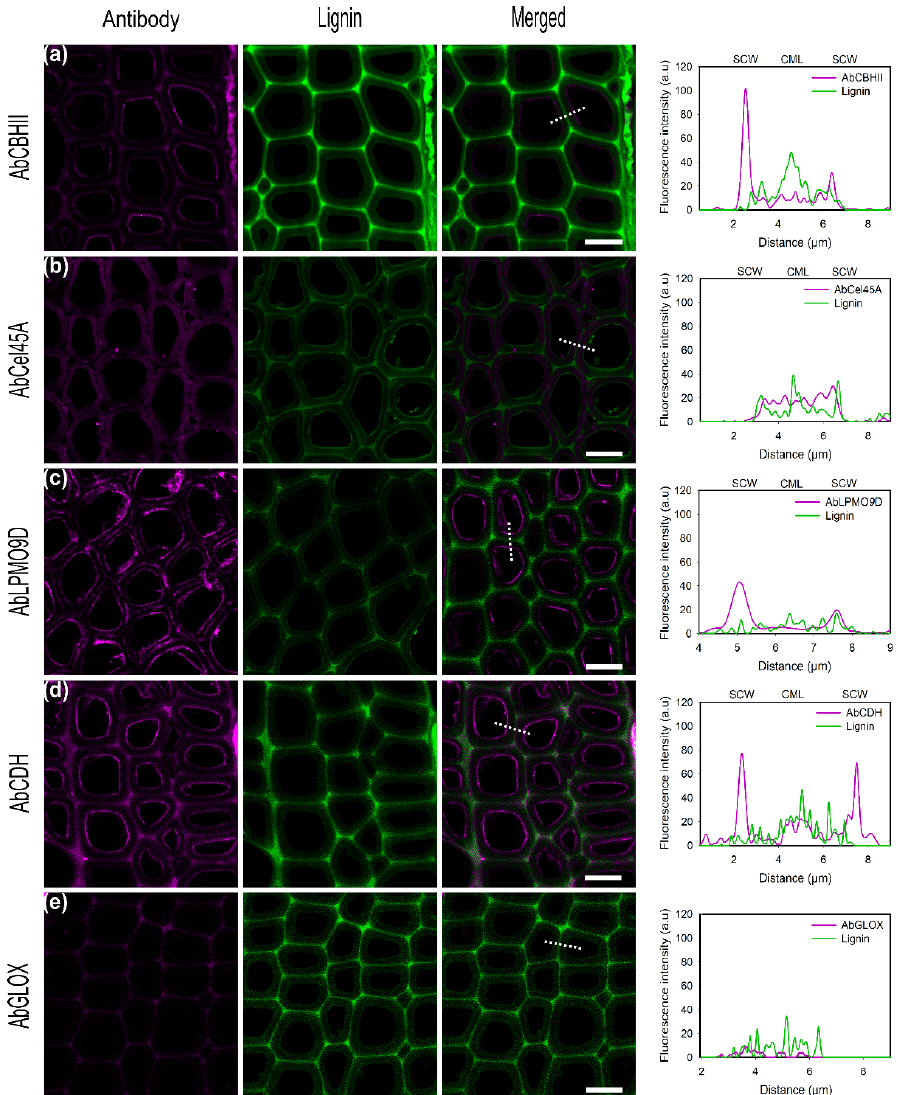
Figure 6. CLSM images of conjugated rabbit polyclonal antibody ( a ) AbCBHII, ( b ) AbCel45A, ( c ) AbLPMO9D, ( d ) AbCDH, ( e ) AbGLOXagainst P. chrysosporium enzymes on poplar cross-sections showing fiber cells. Enzyme fluorescence is colored in magenta. Lignin autofluorescence is shown in green. The merged column displays the overlay of enzyme and autofluorescence channels. Graphs showing overlay profile (dash line) of line scans over fiber cell wall, showing secondary cell walls (SCW) and compound middle lamella (CML). The brightness was enhanced to allow proper visualization using the same factor. Scale bars correspond to 10 µm.